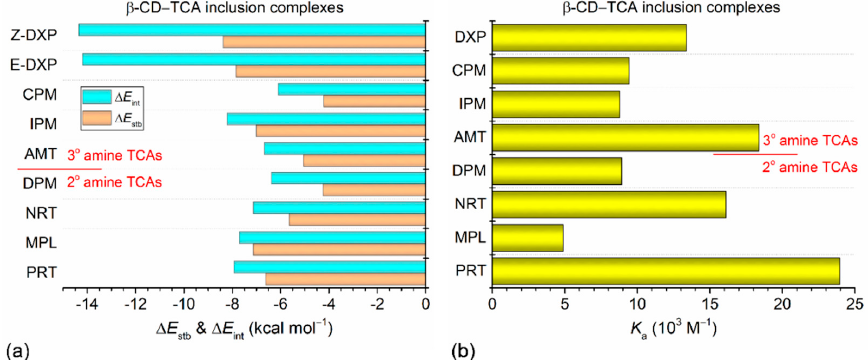
Figure 9. ( a ) Stabilization energy ( ∆ E stb ) and interaction energy ( ∆ E int ) of inclusion complexes β -CD–PRT base and β -CD– MPL base, in comparison to those of other six reported complexes β -CD–NRT base, β -CD–AMT base [23], β -CD–DPM base, β -CD–IPM base [28], and β -CD–CPM base, β -CD– E / Z -DXP base [35], derived from DFT full-geometry optimization in the gas phase; see also Table S7. ( b ) Stability constants ( K a ) are deduced from HPLC and UV data in solution; DXP denotes the racemic mixture of Z -DXP and E -DXP [20,27,29]. The estimated uncertainties of ∆ E = 0.1 kcal mol − 1 and K a = 0.1 × 10 3 M − 1